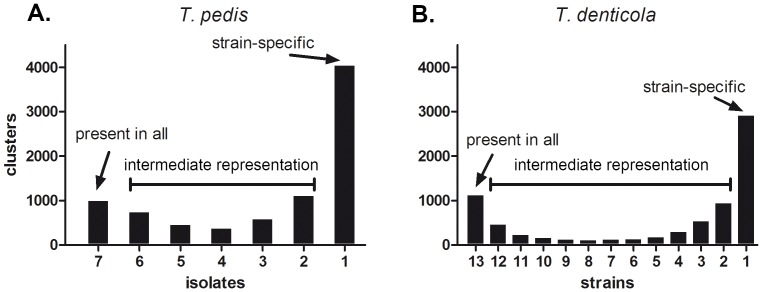
Quantification of strain-specific, intermediately-represented, and core genes in T. pedis and T. denticola.The distribution between strain-specific genes, intermediately-represented genes, and genes present in all genomes, i.e., core functions, in the analyzed genome datasets of T. pedis (A) and T. denticola (B). The gene representation was determined by a clustering analysis that collapsed CDSs sharing >80% BLASTP identity and that had <30% length difference.